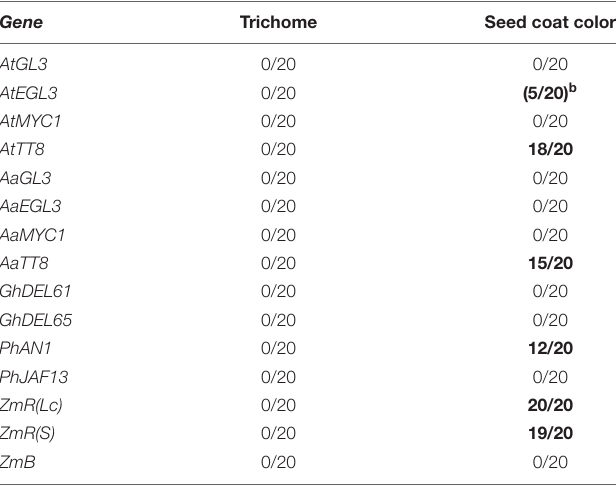
b Seed coat is light brown. Bold values indicate